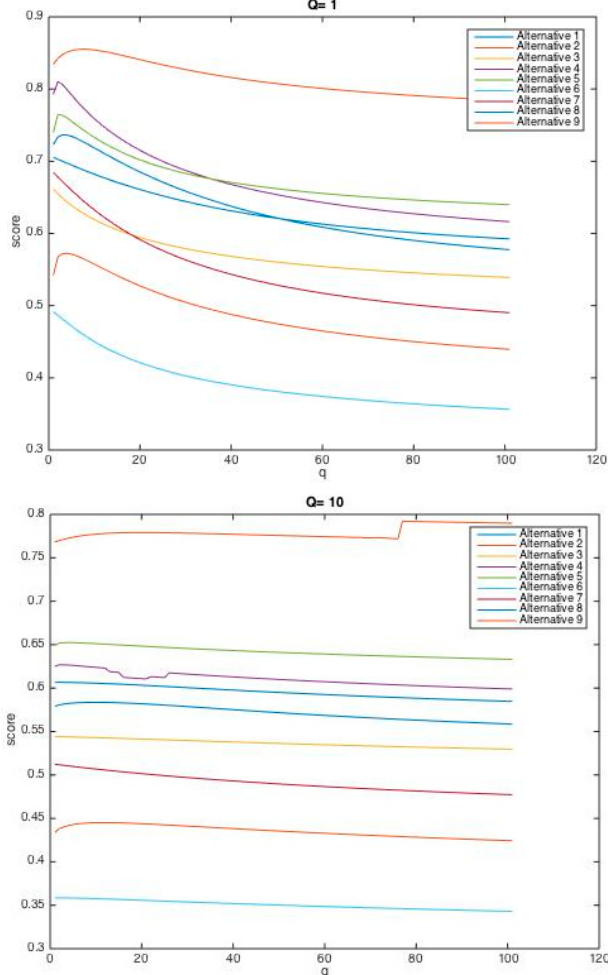
Figure 3. Scores of nine alternatives (p ∈ (0,10]; q = 1, q = 10).